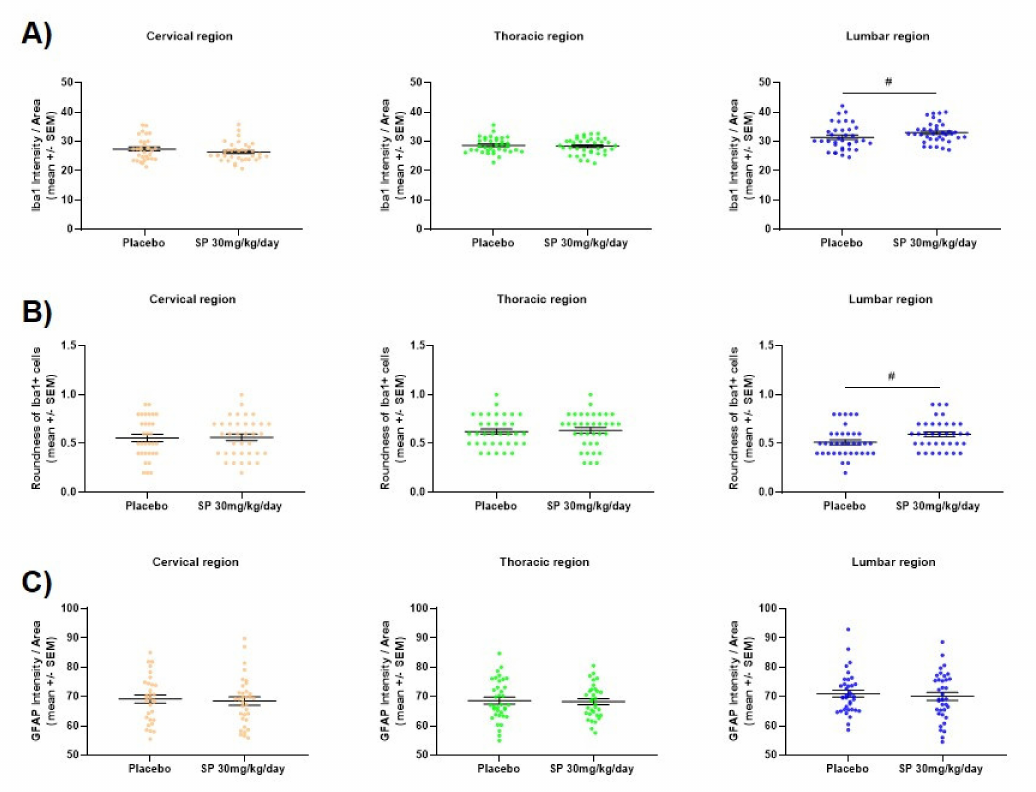
Figure A6. E ff ect of SP treatment on murine spinal cord ( A ) Iba1 fluorescence intensity, ( B ) Iba1 + cell roundness and ( C ) GFAP fluorescence intensity. Spinal cords were extracted from control or SP 30 mg / kg / day-treated EAE-diseased mice (acute phase). Three segments of each spinal cord (cervical, thoracic and lumbar) were evaluated. For each segment, four di ff erent regions of interest were analyzed. Control ( n = 9), SP 30 mg / kg / day ( n = 9) and 3 days of treatment. ( A – C ) immunohistochemistry. Each dot represents a measurement. Abbreviations: SC: Spinal cord, SEM: Standard error of the mean and SP: SP600125. Statistic: Mann–Whitney test, # <